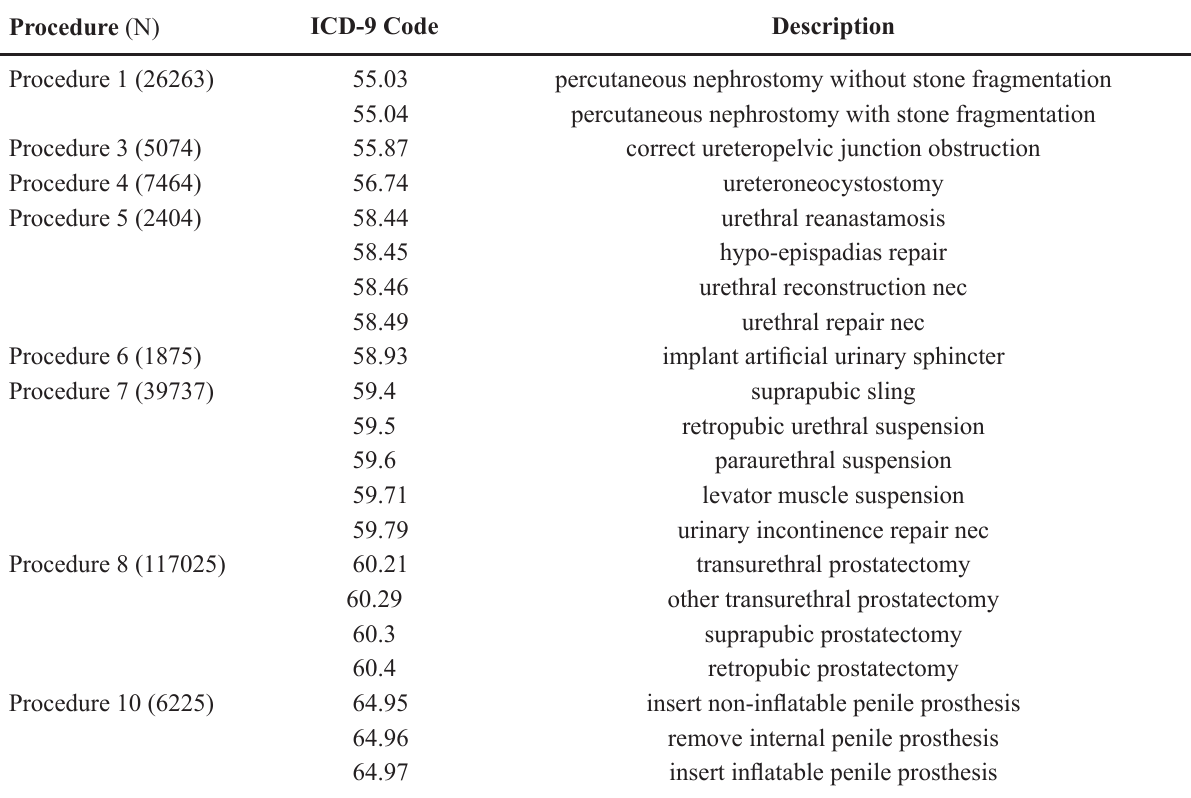
Table 1 – Procedure definitions and corresponding ICD-9